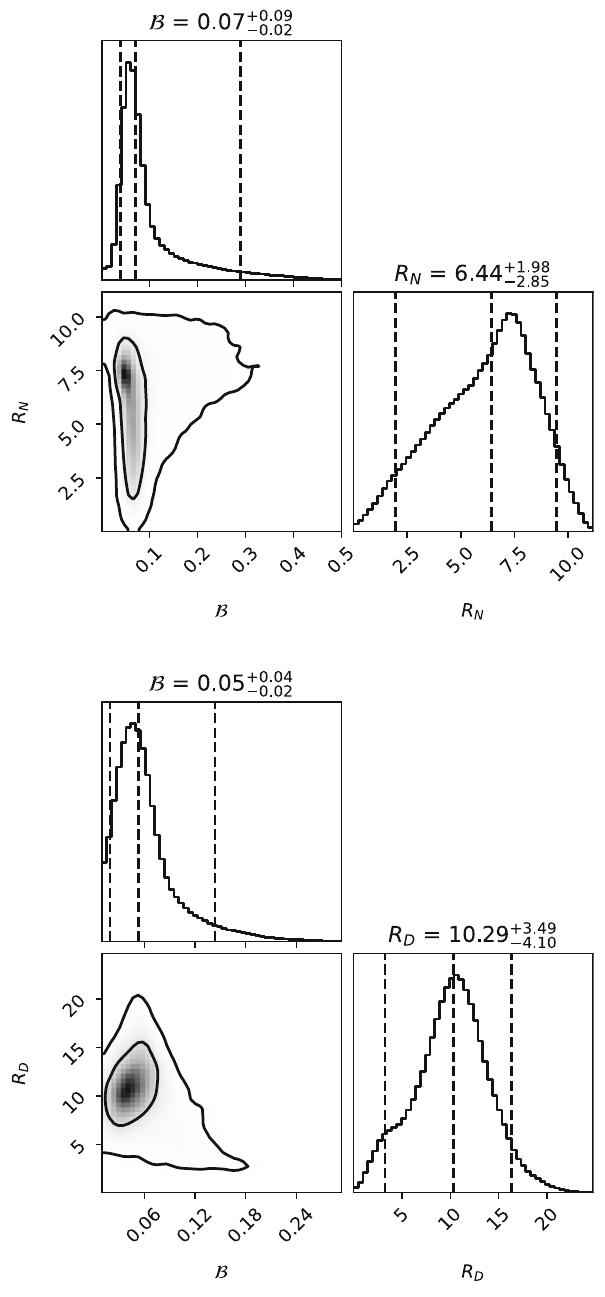
Fig. 14 Posteriors for the dark matter EoS parameter B (horizontal axis) of the SIDM and the core-radius r W (vertical axis) for the first (top sub-figure) and the second (bottom sub-figure) scenarios with neutron SLy4 EoS. The inner circled regions are 50% credible interval, and the outer ones are 90% credible interval. The inferred best-fitted values of B and r W are also given in Table